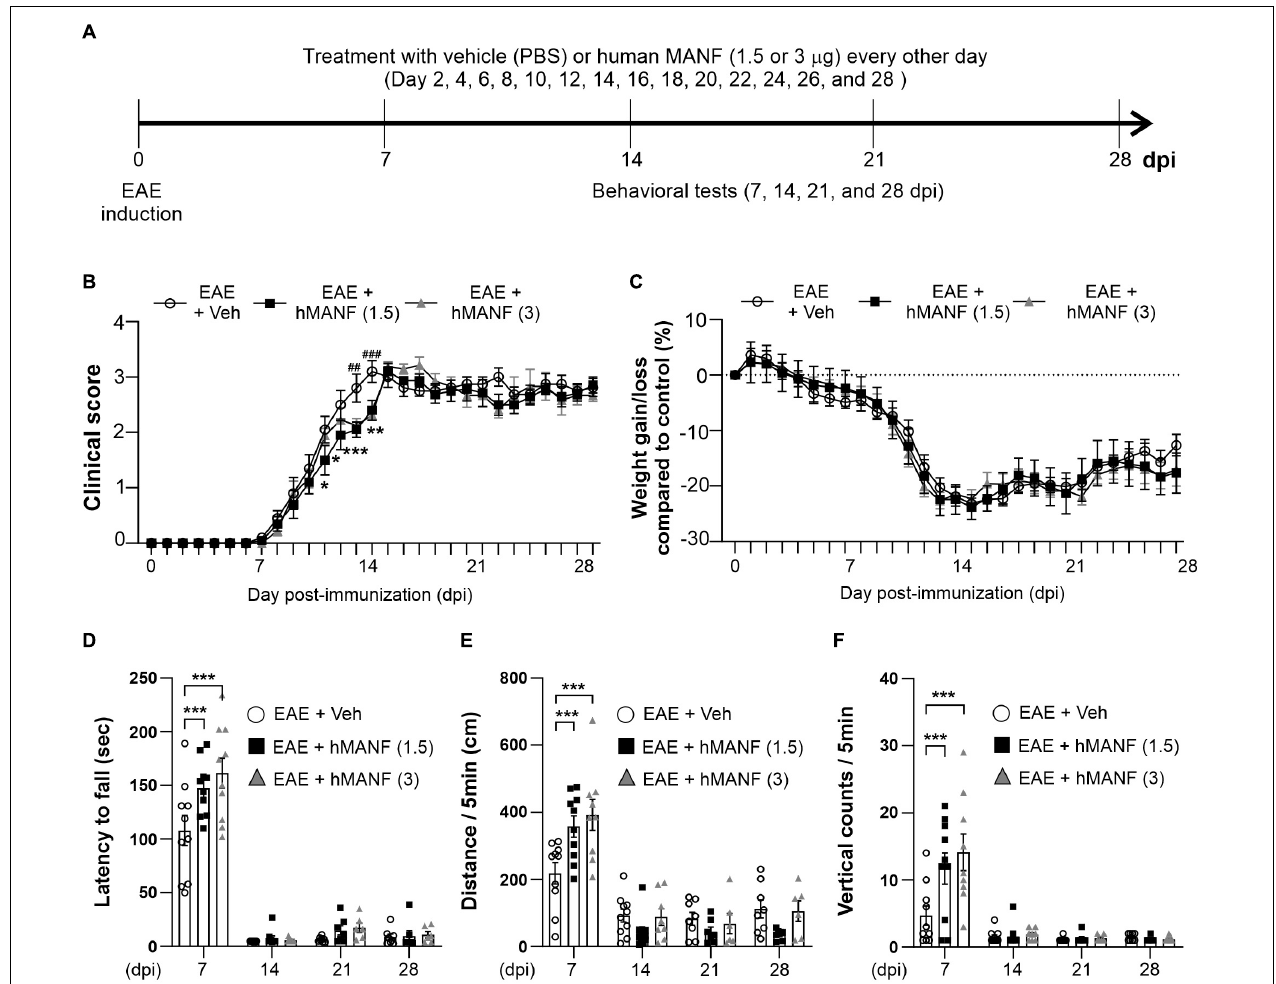
FIGURE 5 | MANF ameliorated clinical signs and reduced motor behavior dysfunction during the early stage of EAE. (A) Diagram of the experiment design. To induce EAE, C57BL/6 were immunized with MOG 35 - 55 /CFA and Pertussis toxin (PTX). Mice received human MANF (1.5 or 3 µ g) or PBS as a vehicle control intravenously (i.v. tail vein) every second day. Mice performed behavioral tests at an interval of 7 days. (B) Mean clinical scores for each day from immunization (0 dpi) to 28 dpi. At * P < 0.05, ** P < 0.01, and *** P < 0.001, treatment with hMANF (1.5 µ g) significantly delayed clinical signs manifestation compared to the EAE group at 11 dpi to 14 dpi, ## P < 0.01, and ### P < 0.001, treatment with hMANF (3 µ g) significantly delayed clinical signs manifestation compared to the EAE group at 13 and 14 dpi. Mean ± SEM, n = 9–10. (C) Gain/loss of body weight. Mean ± SEM, n = 9–10. (D) Latency to fall during the Rotarod test was recorded at 7, 14, 21, and 28 dpi. (E) Distance traveled and vertical counts (rearing-up) was recorded with the open-field test at 7, 14, 21, and 28 dpi. (D–E) *** P < 0.001, Mean ± SEM. n = 9–10. (B–F) 2-way ANOVA was used followed by Tukey’s post hoc test for multiple comparisons. Data from a single independent